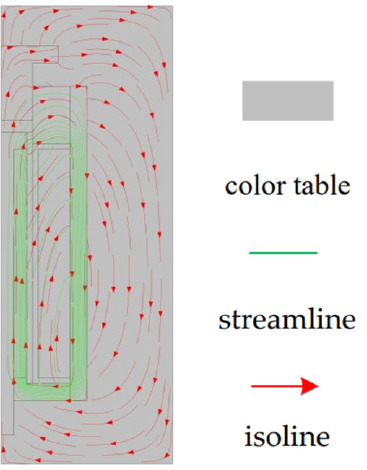
Figure 5. Schematic diagram of GMA magnetic field distribution.